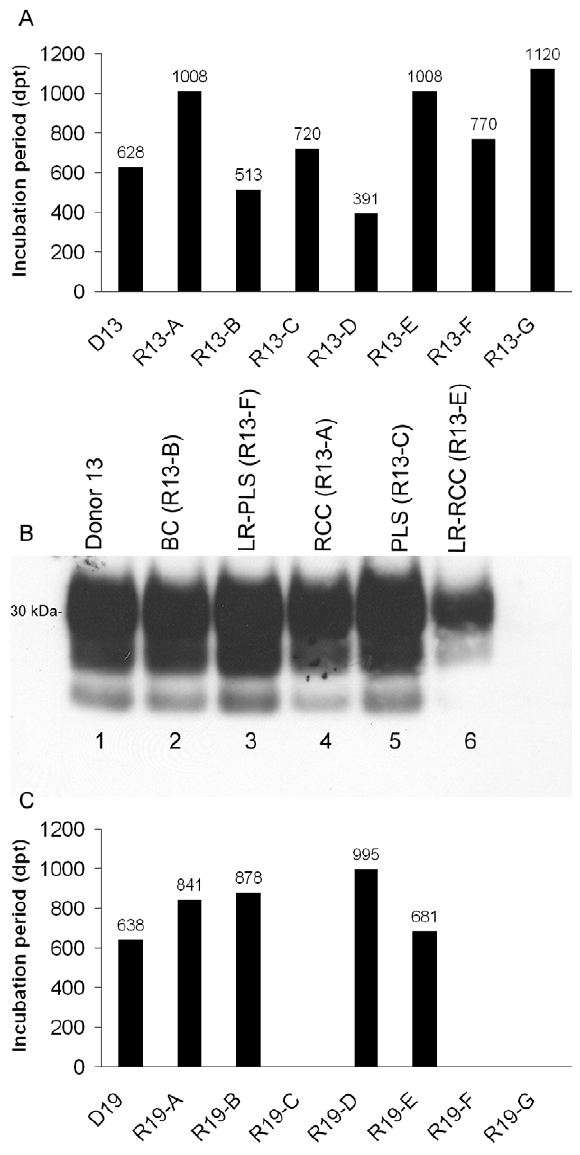
Figure 5. BSE is transmitted following the transfusion of leucoreduced components. Panel A shows the entire repertoire of components prepared from donor 13 (D13) and transfused. The corresponding incubation periods (defined as the date of death based on reaching defined clinical endpoints) is shown in days above the bars. Both platelet recipients (R13-D and R13-G) did not reach clinical endpoint, but were culled for welfare reasons (thus these ‘incubation periods’ correctly refer to the date of euthanasia, in days post transfusion (dpt)). Panel B is a representative immunoblot showing PrP Sc in brain samples of donor 13 (lane 1) and selected, matched transfusion recipients of buffy coat, leucoreduced plasma, red cells, plasma and leucoreduced red cells (lanes 2–6 respectively), thus confirms BSE infection following the transfusion of leucoreduced blood components. Selected recipients of components, including leucore- duced red cells, from donor 19 were also confirmed to have BSE. All of these recipients developed a clinical disease at different time points post transfusion (panel C). Blood from donors 13 and 19 was collected at 48 and 52% of the final incubation period respectively; all later showed typical clinical signs of BSE and were confirmed as positive, as previously described.